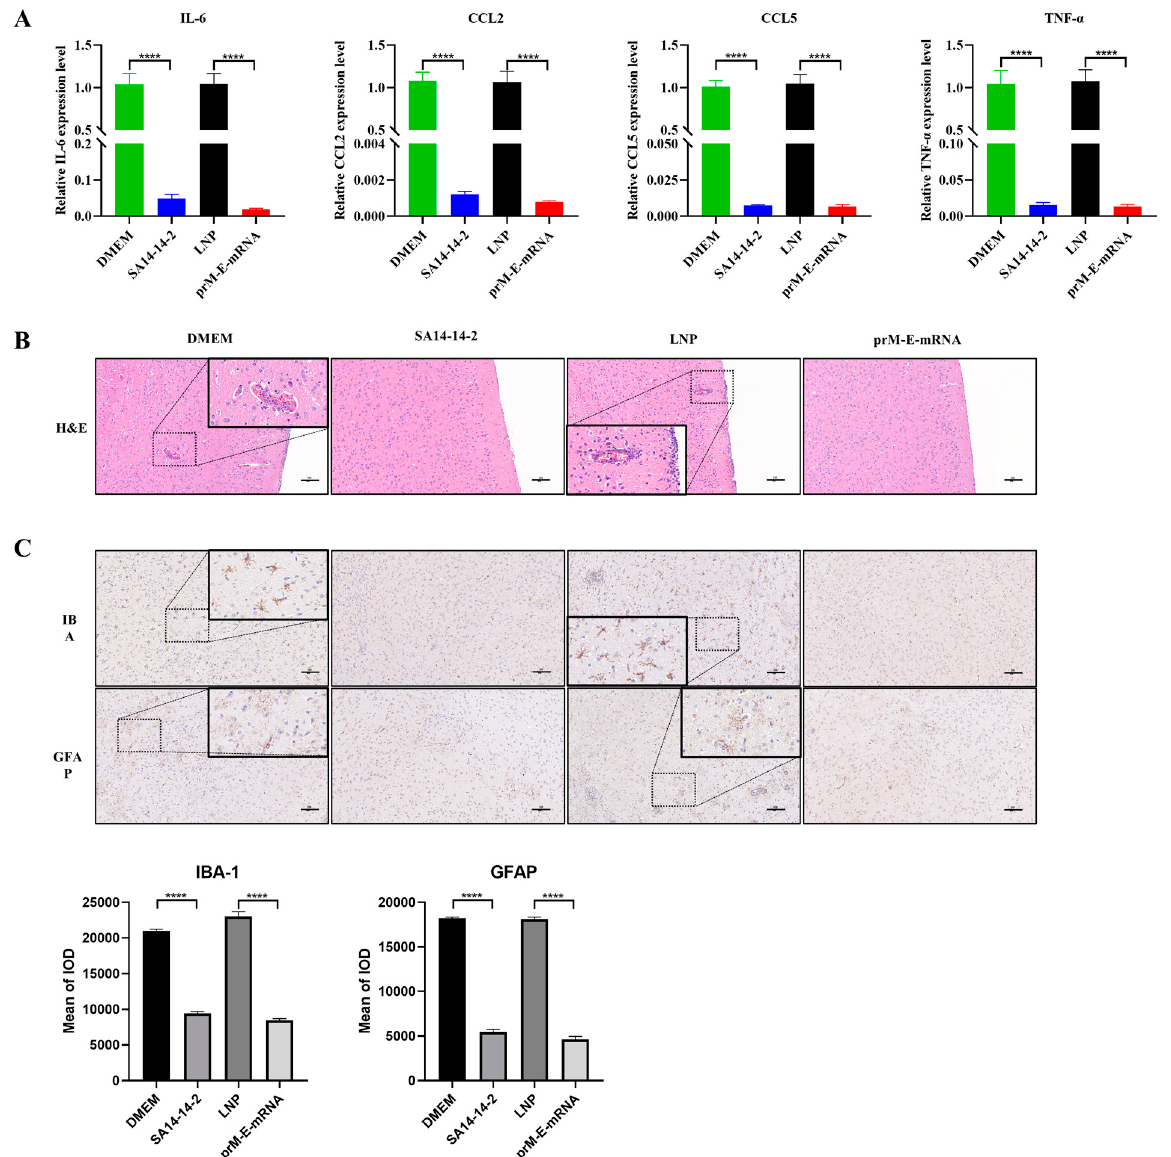
Figure 4. The mRNA vaccine protects against a JEV-induced inflammatory response in mice brain. ( A ) The mRNA expression levels of inflammatory cytokines (IL-6, CCL-2, CCL-5, TNF- α ) in brain tissue lysates were quantified by qRT-PCR. ( B,C ) The activation of the pathological changes and glial cells in brain tissue of mice were analyzed by H&E staining and IHC. Integrated option density analysis of three visual fields of slides from each group was performed to quantify the results of immunohistochemical staining (the lower panels). Scale bar = 100 μ m. Data are represented as mean ± SEM. ( n = 3, **** p < 0.0001).